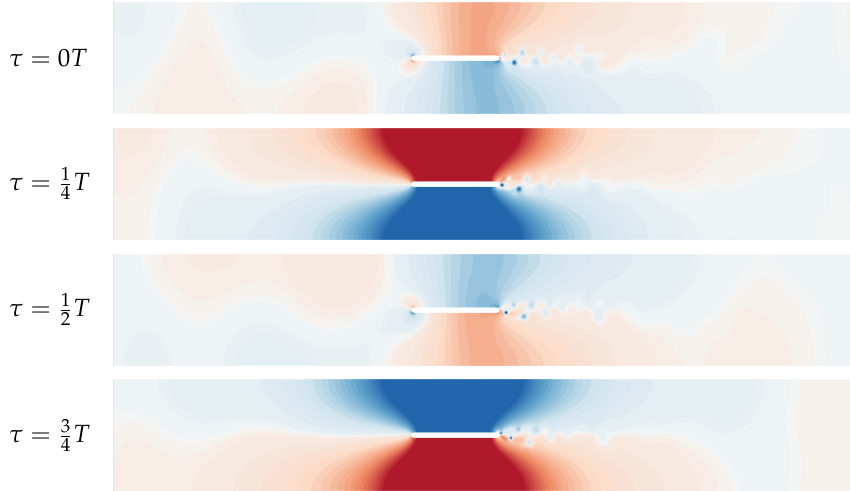
Figure 4. Pointwise difference in instantaneous pressure to time averaged solution. Four instanta- neous snapshots ( τ ) during one period T of 530Hz for a simulation with v x ≈ 27.4m/s are shown. Mapped colors correspond to [ − 1000,1000 ]